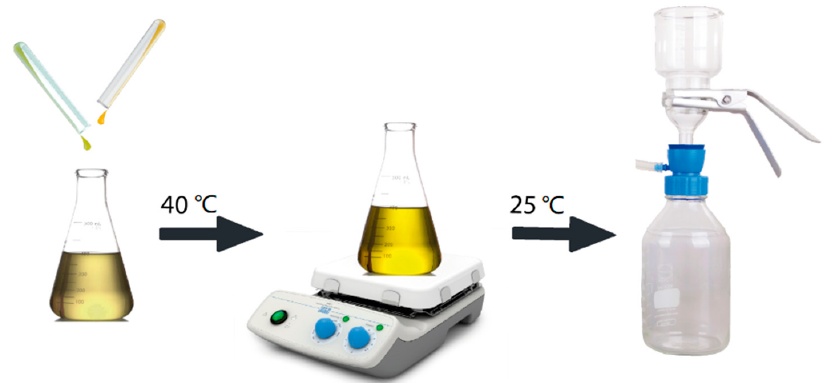
Figure 8. General scheme of the complexation